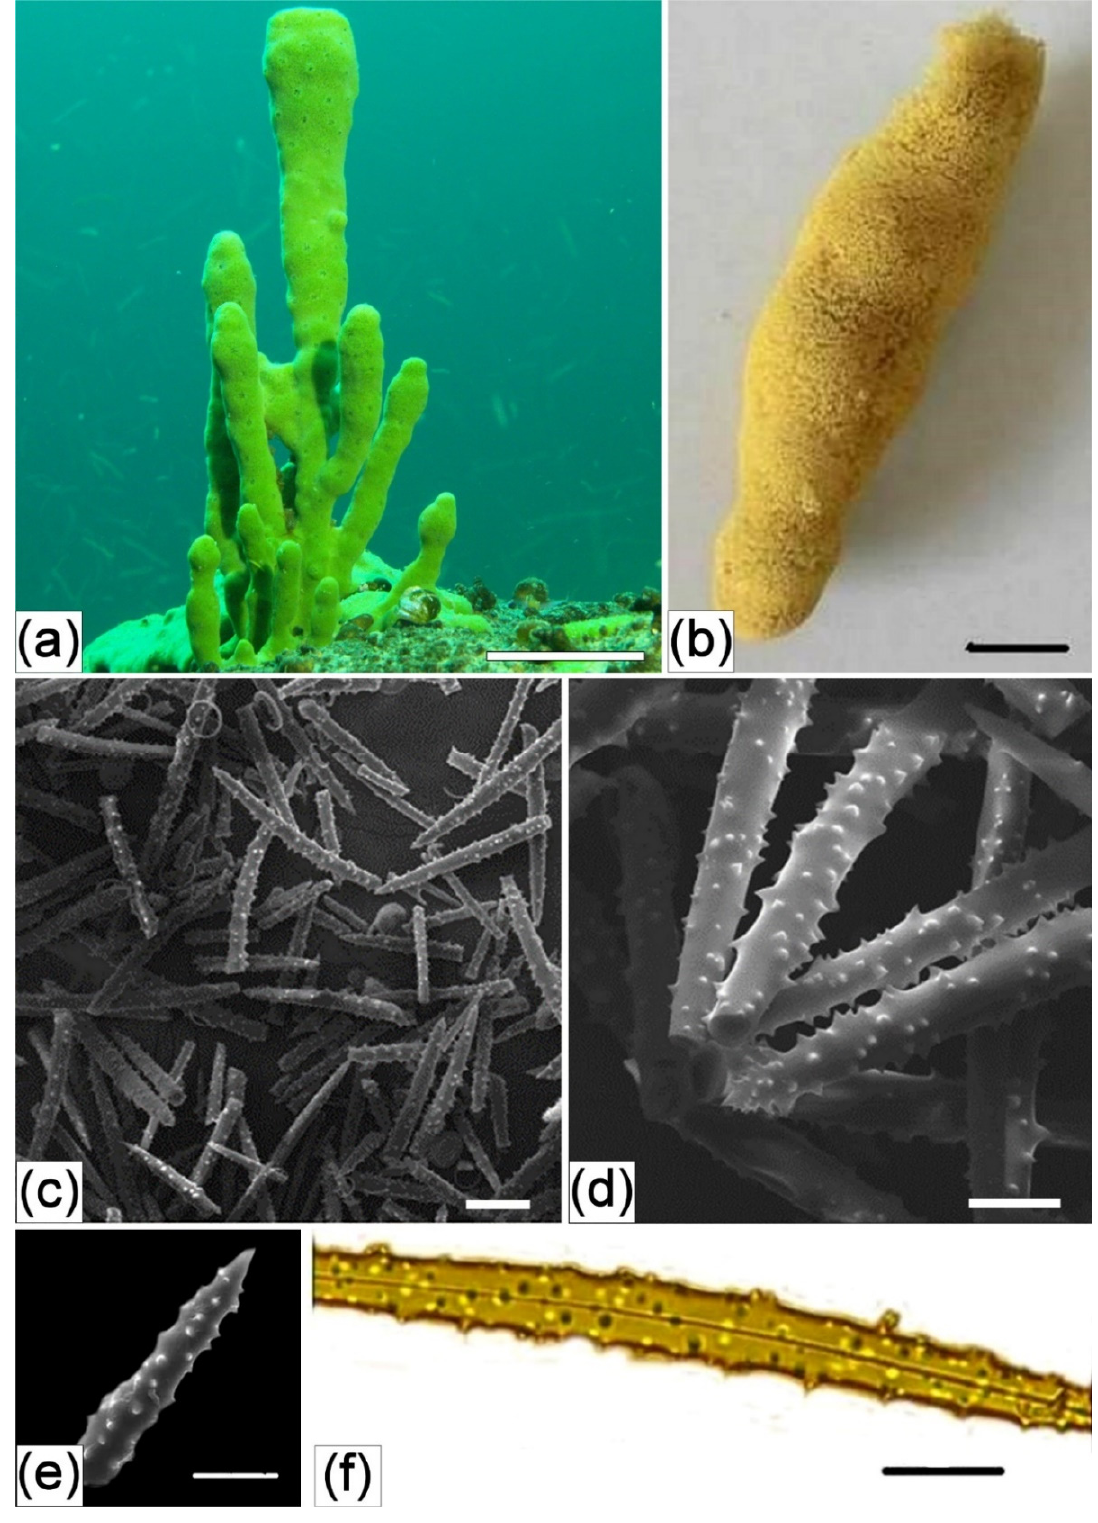
Figure 10. Lubomirskia baicalensis. Morphological feature ( a , b ) and the ultrastructure of the spicules by SEM ( c – f ). Scale: ( a )—15 cm, ( b )—2 cm, ( с )—40 μ , ( d )—20 μ , ( e )—20 μ , ( f )—10 μ .